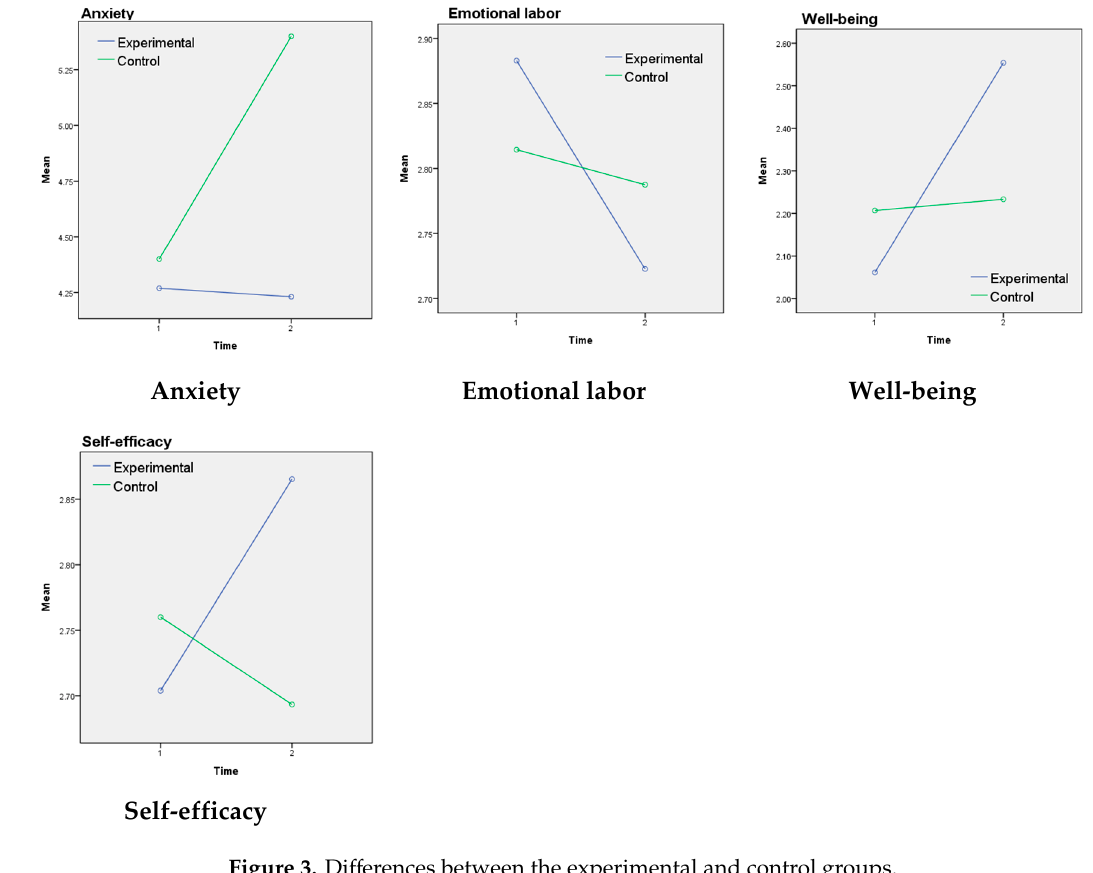
Figure 3. Di ff erences between the experimental and control groups. Figure 3. Differences between the experimental and control groups. Table 4. The users’ satisfaction and experience with the app ( N =